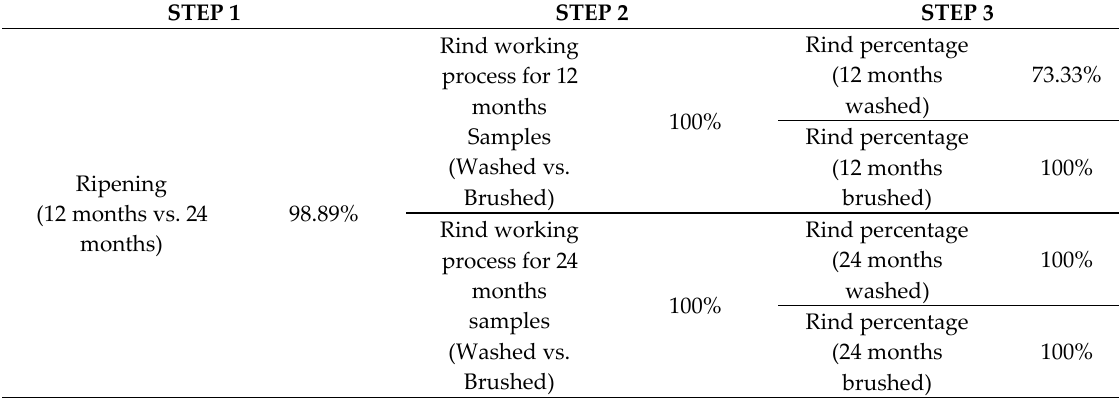
Table 1. Classification rates of ANNs for each